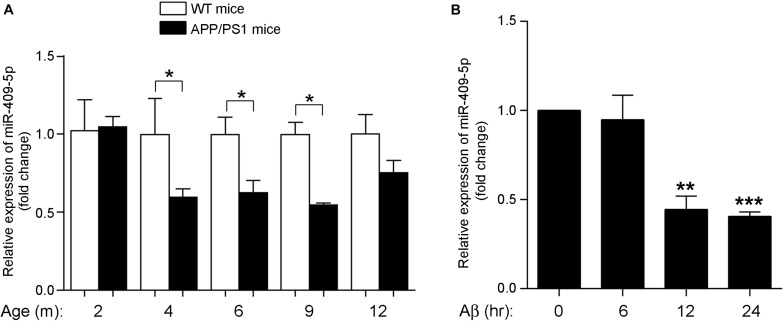
MiR-409-5p was significantly decreased in APP/PS1 mouse and oligomeric Aβ1–42 peptide-treated cells. (A) Relative expression levels of miR-409-5p were quantified by RT-qPCR in cortex tissues of APP/PS1 and wild-type (WT) mice from 2 to 12 months (4–6 mice for each age). The levels were normalized to the expression of snRNAU6. The results were shown as the mean ± SD (∗p < 0.05, n = 3). Two-way ANOVA was used to analyze differences. (B) PC12 cells had differentiated for 48 h. The diluted Aβ1–42 was incubated at 37°C overnight to induce aggregation, then 4 μM oligomeric Aβ1–42 per well in differentiation medium of PC12 cells. Relative expression level of miR-409-5p was examined by RT-qPCR at different time points. The results were shown as the mean ± SD (∗∗p < 0.01, ∗∗∗p < 0.001). The experiment was repeated independently for three times. ANOVA followed by post hoc analysis using Dunnett’s test was used to analyze differences.